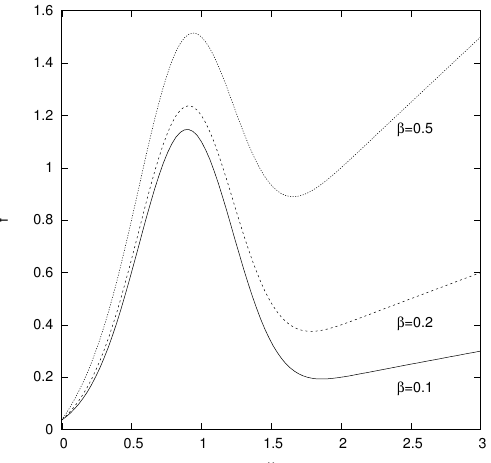
Figure 1. Graphs of the iteration function f ( α , β , x ) with α = 4 and with different values of β